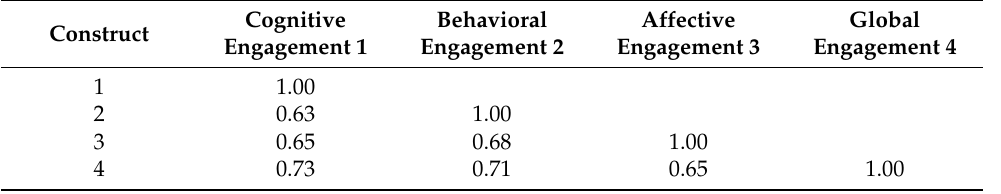
Table 3. Correlations between the three students’ engagement.